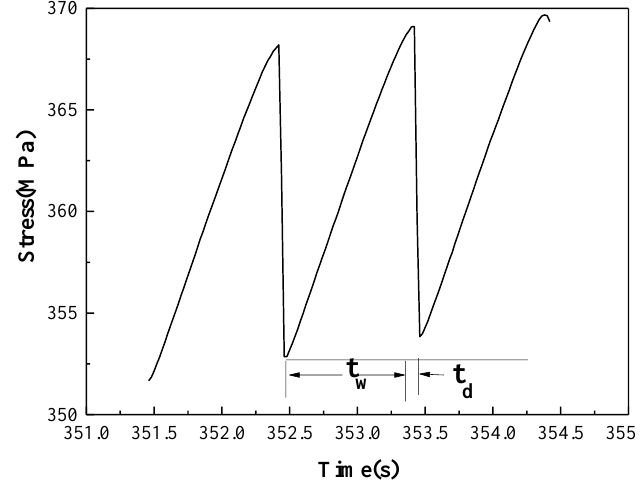
Figure 2 . Schematic diagram of the waiting time (t w ) and falling time (t d ). Figure 2. Schematic diagram of the waiting time (t